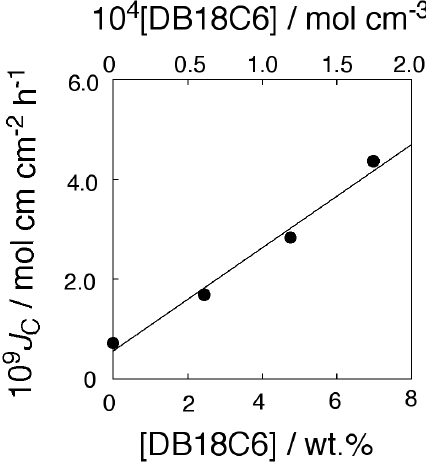
Figure 4. Relationship between KCl flux and the DB18C6 concentration through the PC18AAm liquid membranes (Operating temperature, 50 °C (323 K); [KCl] 1.0 × 10 − 4 mol·cm − 3 ).